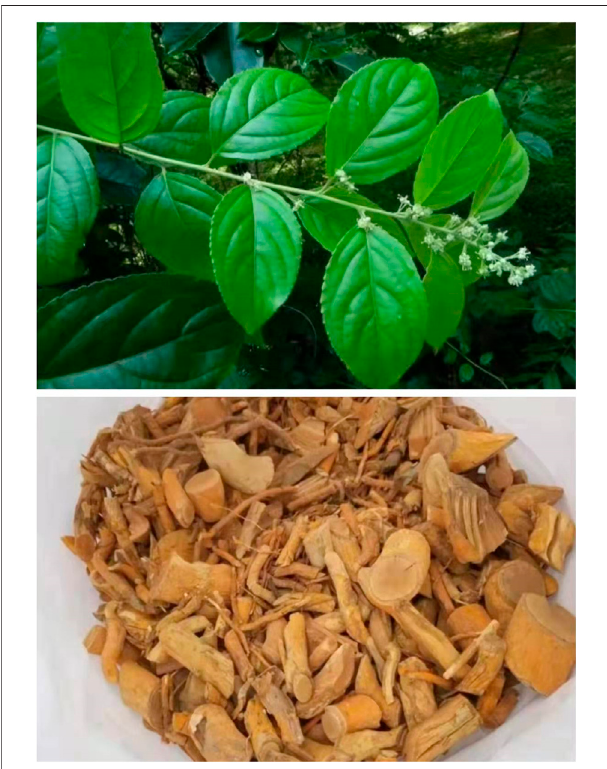
FIGURE 1 | Traditional Chinese botanical